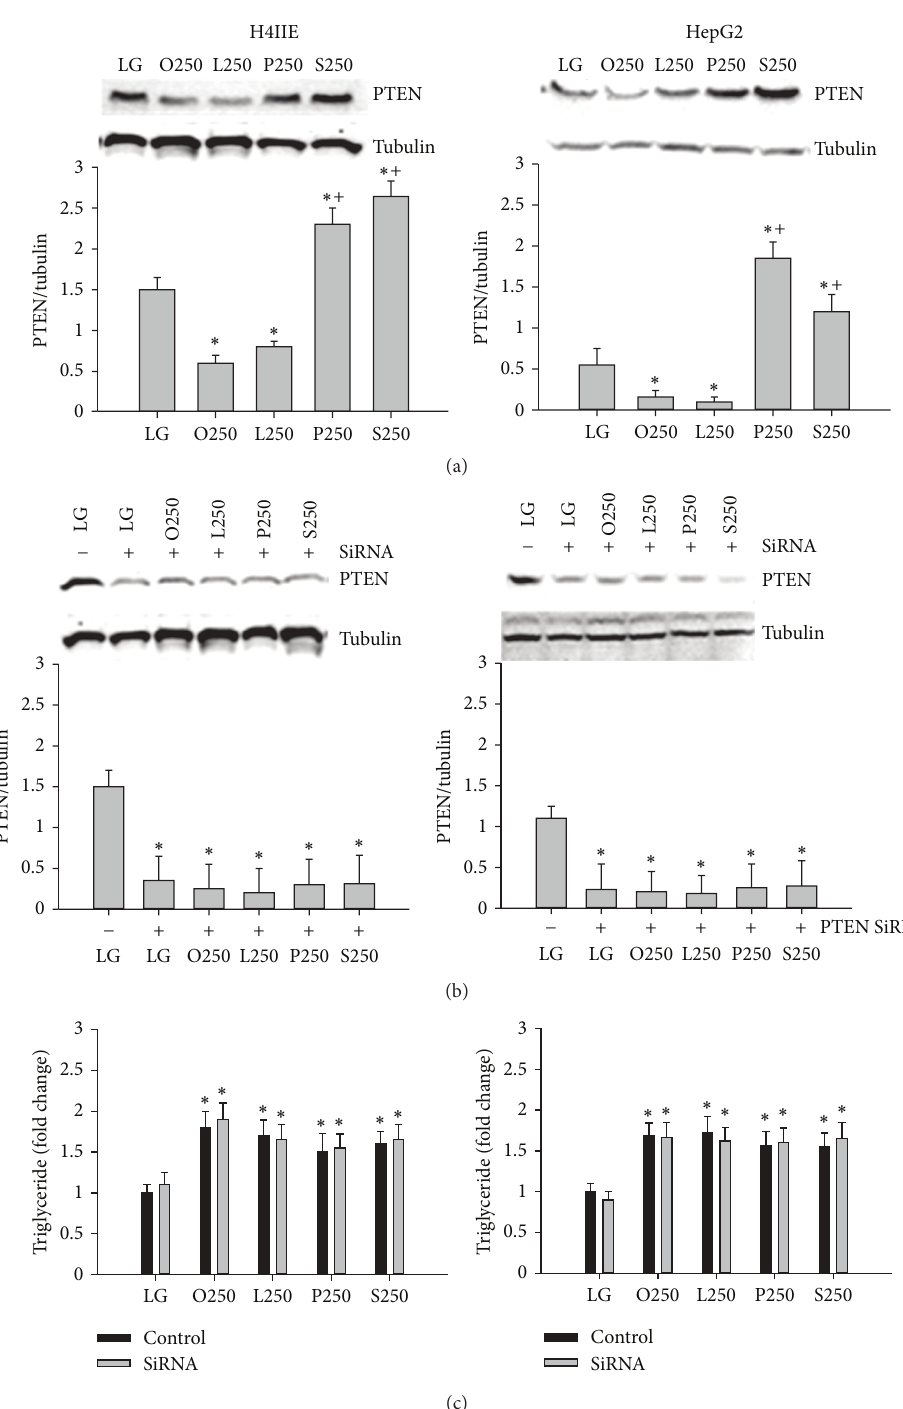
Figure 1: PTEN expression and effects of PTEN knockdown on triglyceride stores in liver cells. PTEN protein expression following 16h of incubations with control media (LG) or fatty acids (oleate (O), linoleate (L), palmitate (P), or stearate (S)) at 250 𝜇 M (a) in H4IIE (left column) or HepG2 (right column) liver cells ( 𝑛 = 6 ). Effectiveness of SiRNA-mediated knockdown of PTEN in liver cells (b). Effects of SiRNA-mediated knockdown of PTEN on triglyceride stores in liver cells following 16h of incubations with control media or fatty acids (c). ∗ : significantly ( 𝑃 < 0.05 ) different from LG; + : significantly ( 𝑃 < 0.05 ) different from O250 and